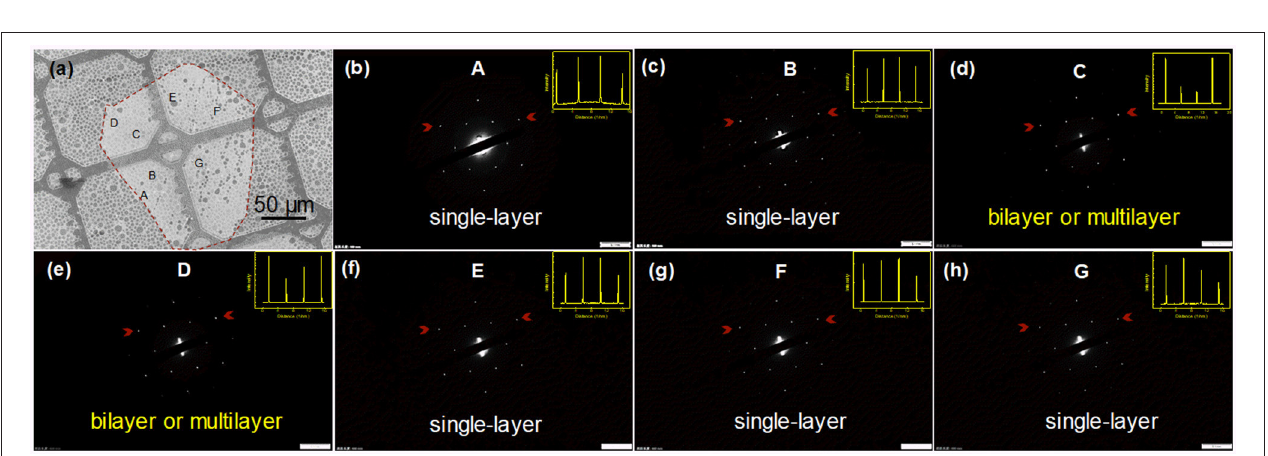
FIGURE 4 | Raman characterization of the obtained graphene domains. (a) Optical image of graphene domains transferred to the SiO 2 /Si surface. (b) Raman spectra of the black point and the red point marked in a. (c–f) Raman intensity mapping results of (c) D, (d) G, (e) 2D, and (f) G/2D bands of the region marked by red rectangle in (a) .